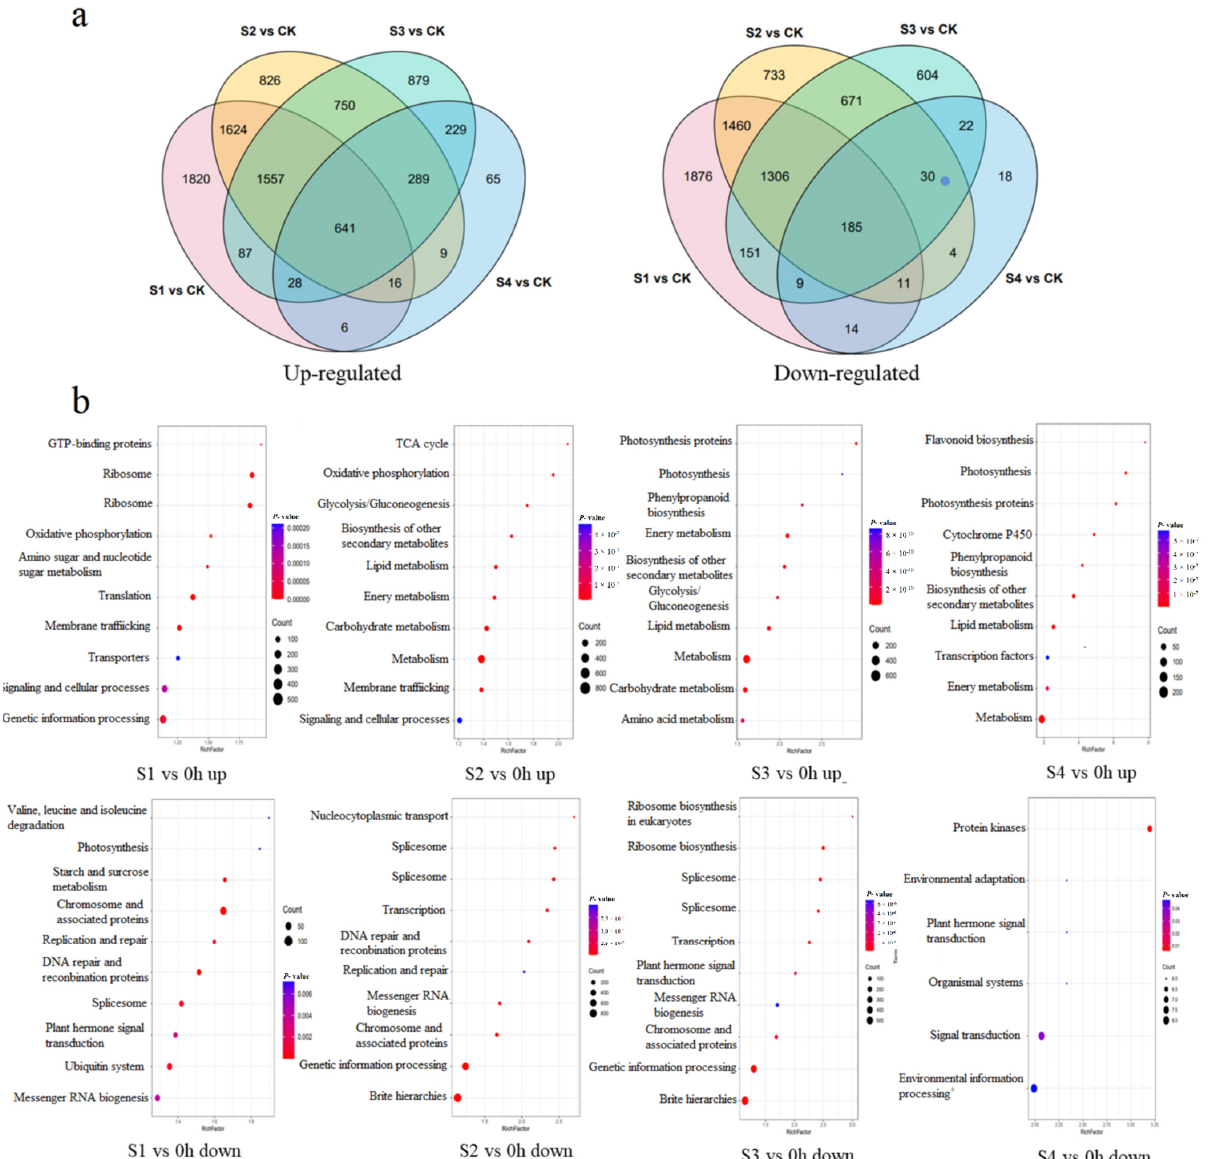
Figure 2. DEG analysis in different stages after wounding: ( a ) Venn diagram of DEGs in different stages; ( b ) KEGG enrichment of DEGs in different stages.